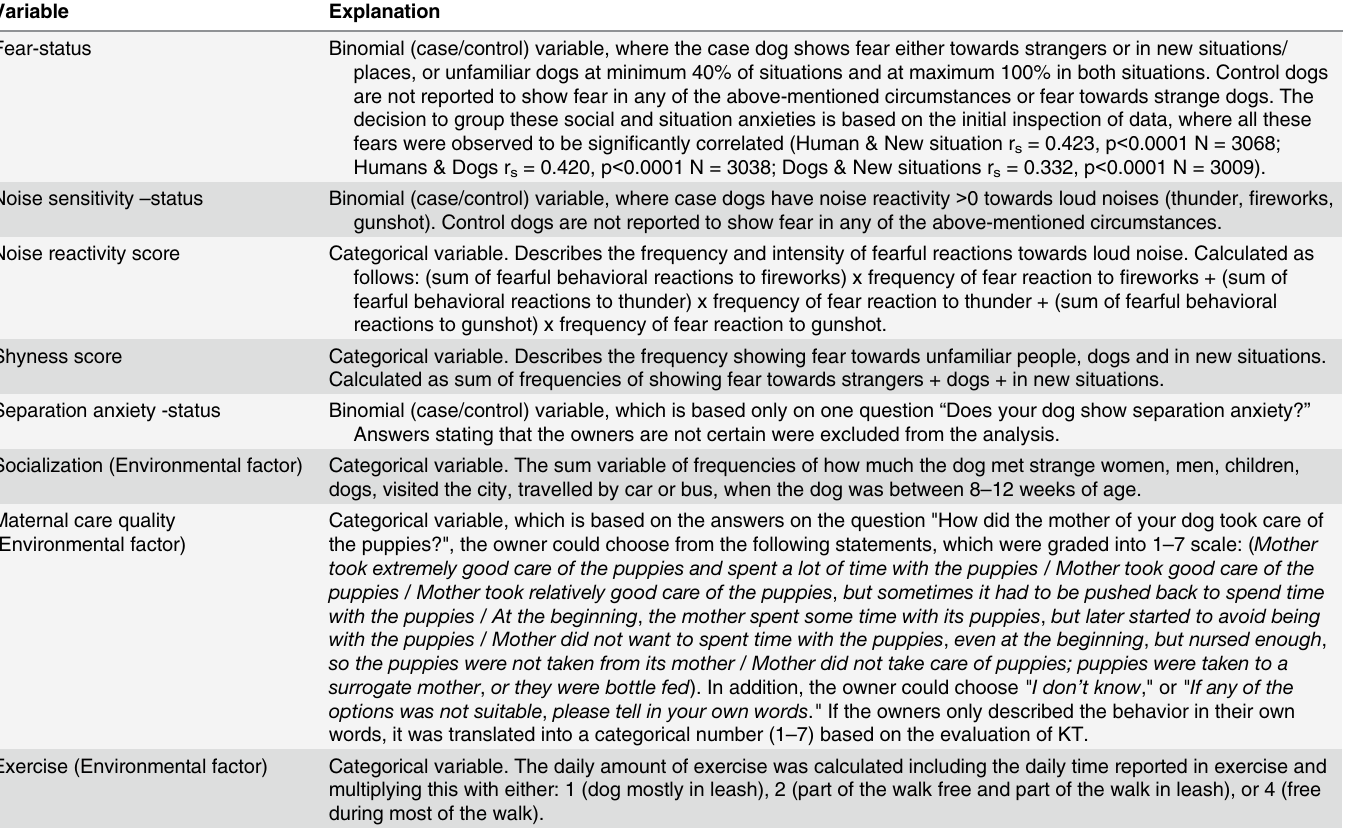
Table 1. Behavioral and environmental variables derived from questionnaire